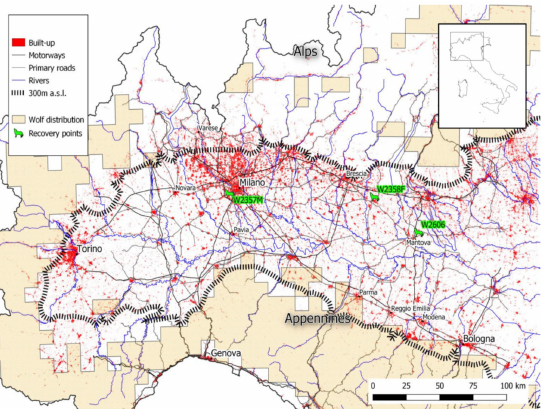
Figure 1. The study area in Northern Italy with wolf distribution, obtained from the report on the species of community interest (2013–2018) and updated with more recent data (2022), and recovery sites of the three